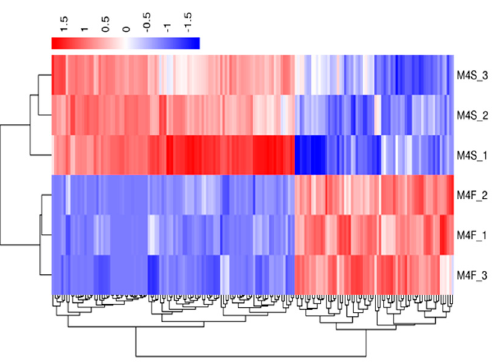
Figure 2. Venn diagram of differentially expressed genes. ( a ) Venn diagram of differentially expressed genes for four-week old males and females. ( b ) Venn diagram of differentially expressed genes for eight-week old males and females. ( c ) Venn diagram of differentially expressed genes for four-week and eight-week-old males. ( d ) Venn diagram of differentially expressed genes for four-week and eight-week-old females.